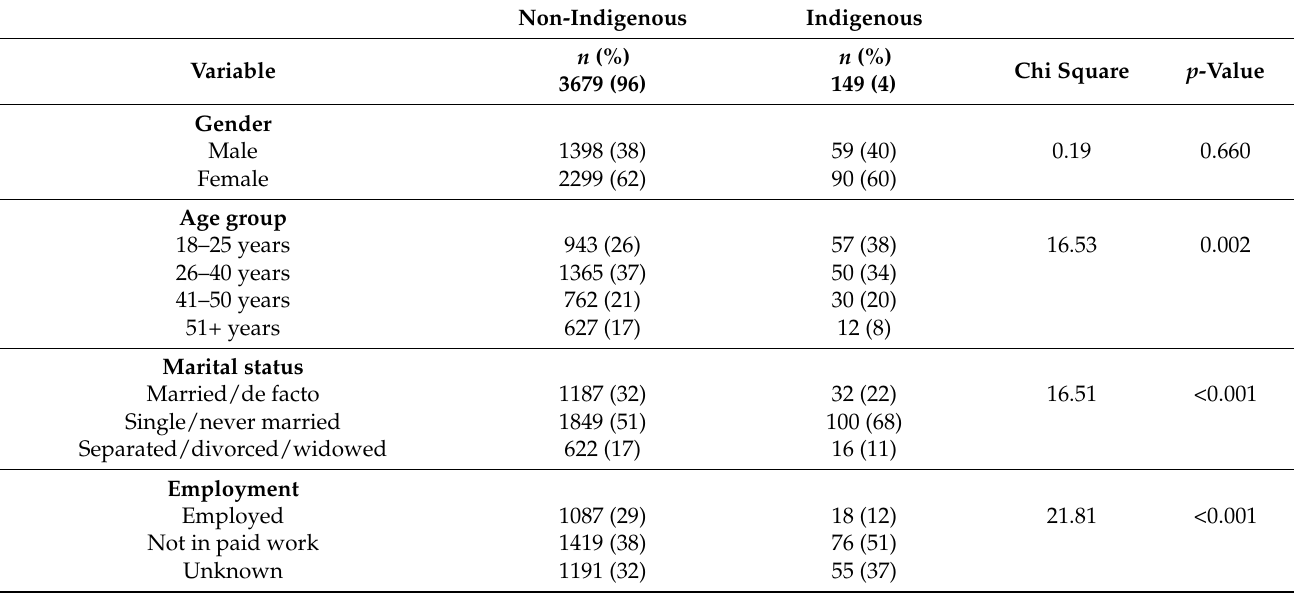
Table 1. Demographic and Clinical Characteristics by Cultural